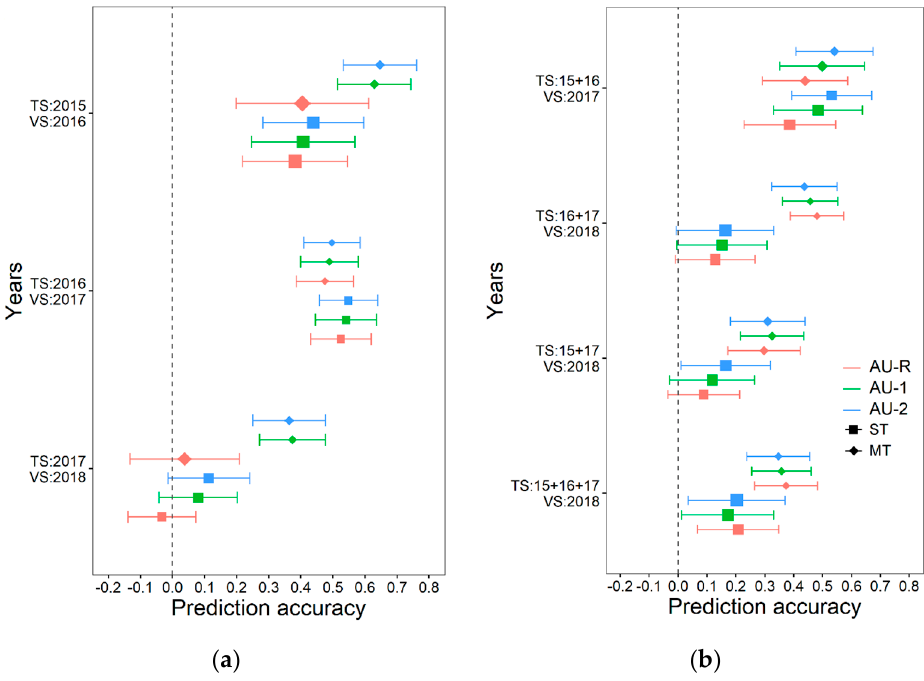
Figure 2. Prediction accuracies PA for the proposed genomic selection schemes: ( a ) For GS models with training sets composed of lines from single trials and ( b ) with training sets composed of lines from combined trials. TS and VS stand for training and validation sets, respectively. AU-R, AU-1, and AU-2 stand for area under the disease progress curve (AUDPC) scores either uncorrected or corrected under method-1 or method-2, respectively. ST and MT explain whether the GS model included disease severity alone or anther retention was included as an assisting trait, respectively. Standard deviations are presented as the length of each segment, and the width of either the squares or diamonds correspond to the 95% confidence interval.